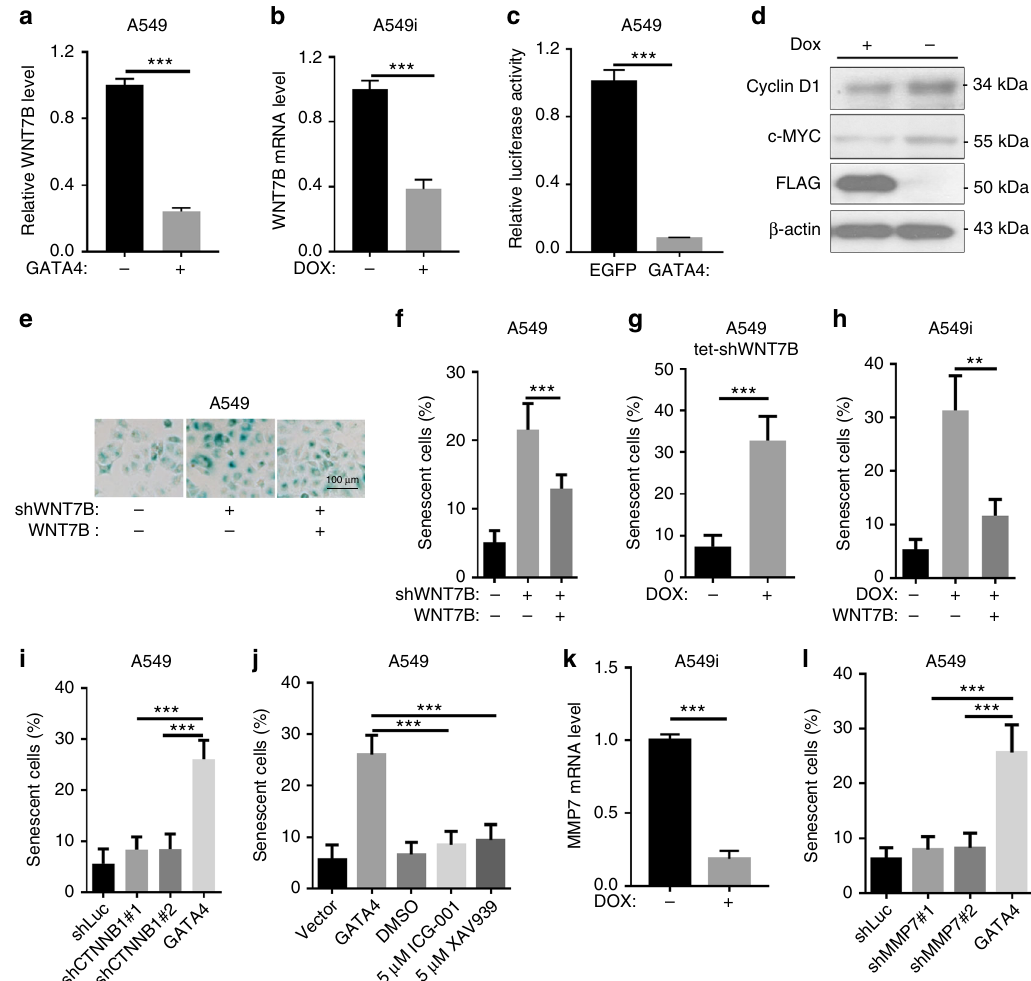
Fig. 3 GATA4 induces lung cancer cell senescence by downregulating WNT7B. a and b WNT7B expression level in A549 cells ectopically expressing GATA4 through lentivirus infection ( a ) or Doxycycline treatment of A549i cells ( b ) ( n = 3 per group). c TOP-FLASH analysis of GATA4 expressing A549 cells ( n = 6 per group). d Western blot analysis of c-Myc and cyclin D1 in A549i cells in the absence or presence of 2 μ g/mL of Dox. e β -Galactosidase staining of A549 cells expressing WNT7B targeting shRNA (middle panel) and rescued by shRNA-resistant WNT7B (right panel) (scale bar 100 μ m). f Statistics of e ( n = 3 per group). g β -Galactosidase staining of A549 expressing Dox-inducible shRNA targeting WNT7B (A549 tet-shWNT7B) in the absence or presence of 2 μ g/mL of Dox ( n = 3 per group). h β -Galactosidase staining of A549i in the absence or presence of 2 μ g/mL of Dox and